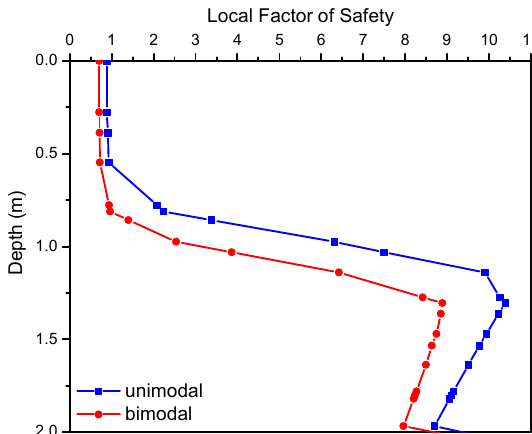
Figure 11. The variation of the LFS with depth in unimodal and bimodal models (at 48 h).